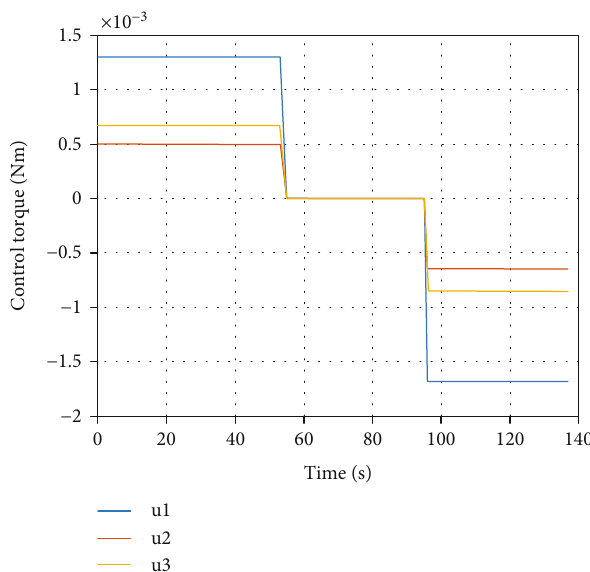
Figure 11: Control torque time history based on the grey wolf optimizer.